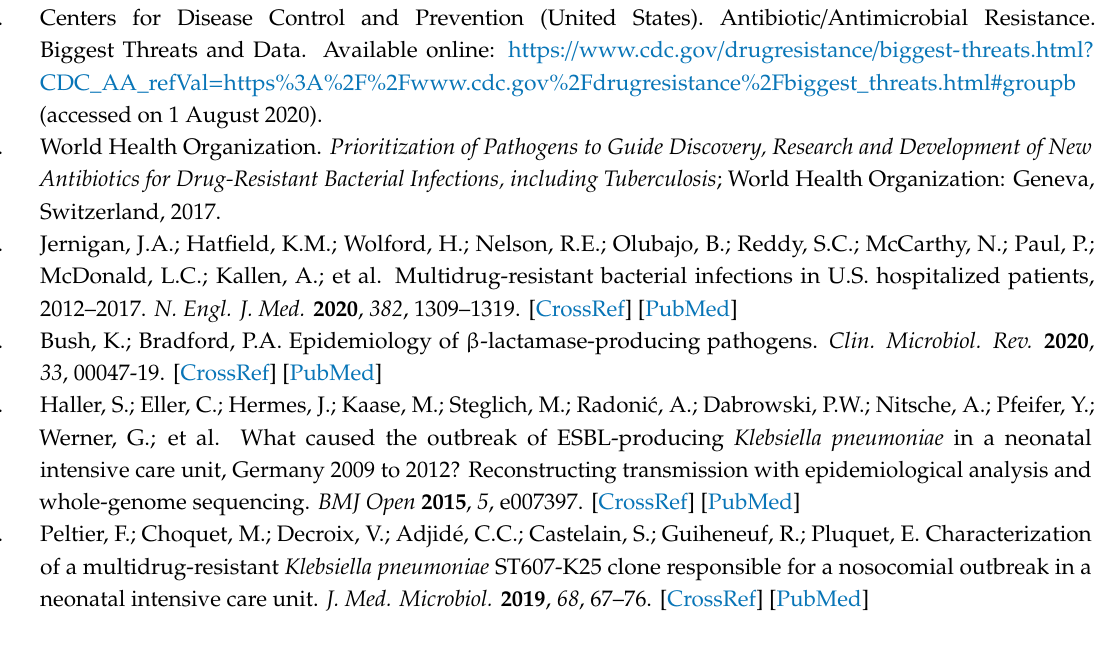
Table S1. List of isolates and their accession numbers, BOX-PCR clade and antibiogram along with assembly statistic, dates, and clinical source. Table S2. Genetic characteristics of genomes found in outbreaks of ESBL-producing K. pneumoniae in three neonatal intensive care units. Table S3. List of KpI reference genomes used to build the KpI phylogenetic tree. Figure S1. Core-genome alignment phylogenetic tree of ST35 genomes from NICU-2 and NICU-3 isolates together with 21 ST35 genomes from the SRA database. ST35 genomes from NICU-2 and NICU-3 isolates are monophyletic and have almost no dissimilarity distance. Figure S2. Plasmid replication control loci presence and absence according to the PlasmidFinder database and pMLST typing based on PubMLST. The asterisks indicate the dominant clone in each neonatal intensive care unit (NICU). Figure S3. ISEcp1-blaCTX-M-15 elements from di ff erent isolates show di ff erent flanking regions. AR genes are marked according to the